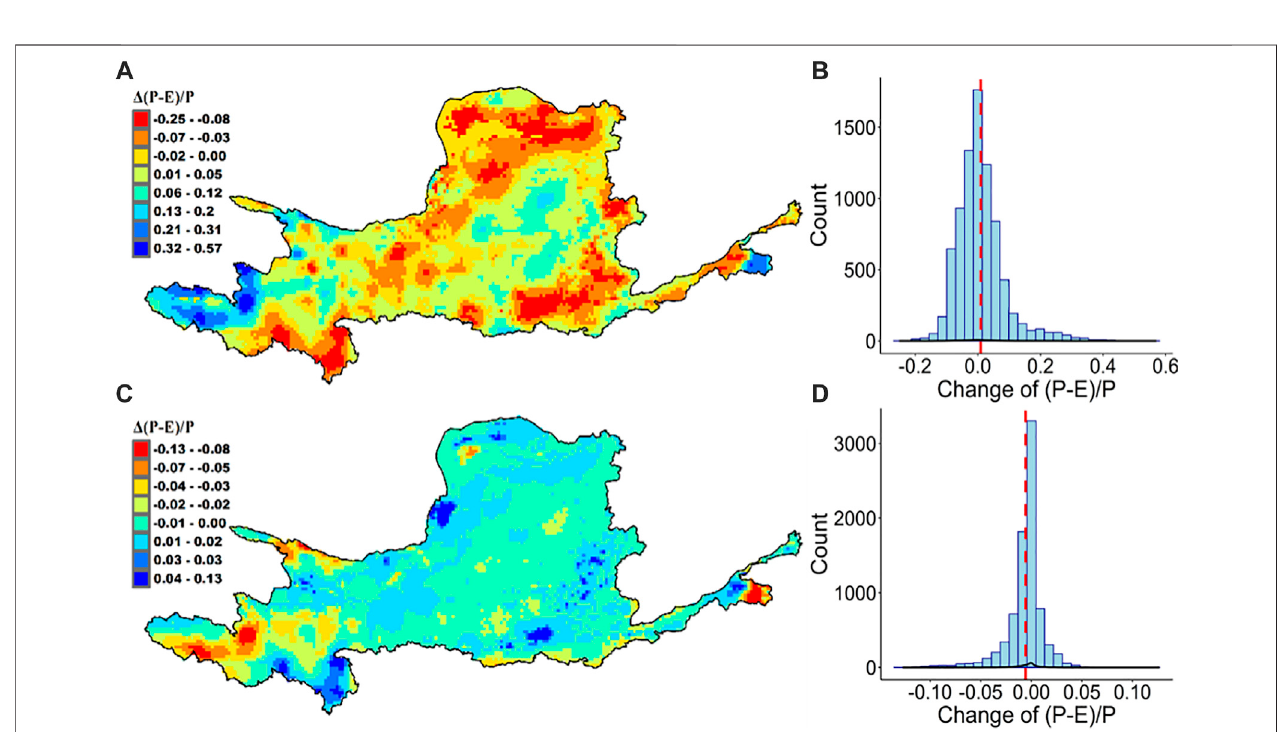
FIGURE 3 | Contributions of P and E changes to Δ (P – E)/P (total dry-season water resources). (A,B) Spatial pattern of Δ P contribution to Δ (P – E)/P and its corresponding density distribution. (C,D) Spatial pattern of Δ E contribution to Δ (P – E)/P and its corresponding density distribution.